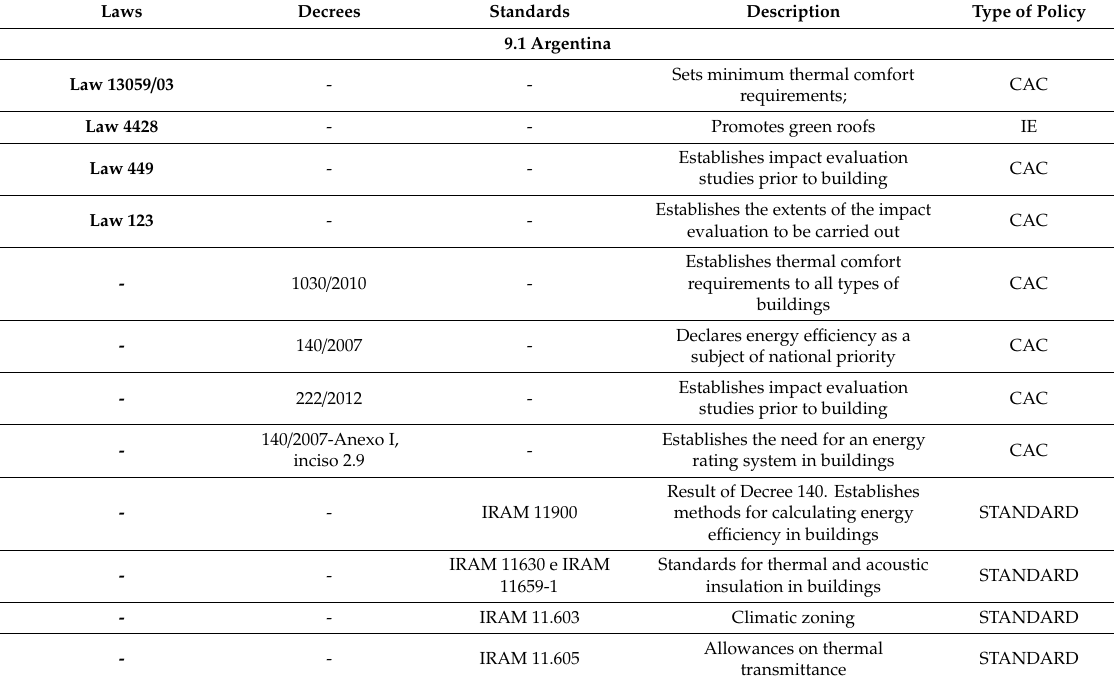
Table A1. List of the reviewed GBR’s, listed by country’s alphabetical